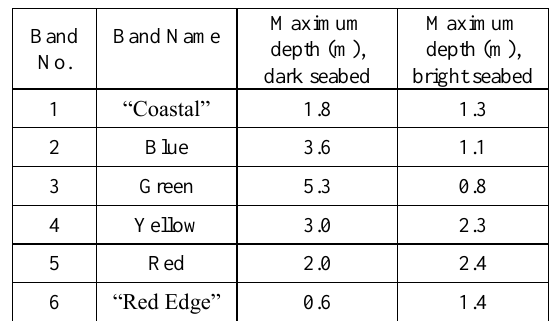
Table 2. Maximum depth where the absolute value of depth derivative of reflectance exceeds 0.0016 sr -1 m -1 for the first six spectral bands of WorldView-2, for typical coastal sea waters with dark and bright